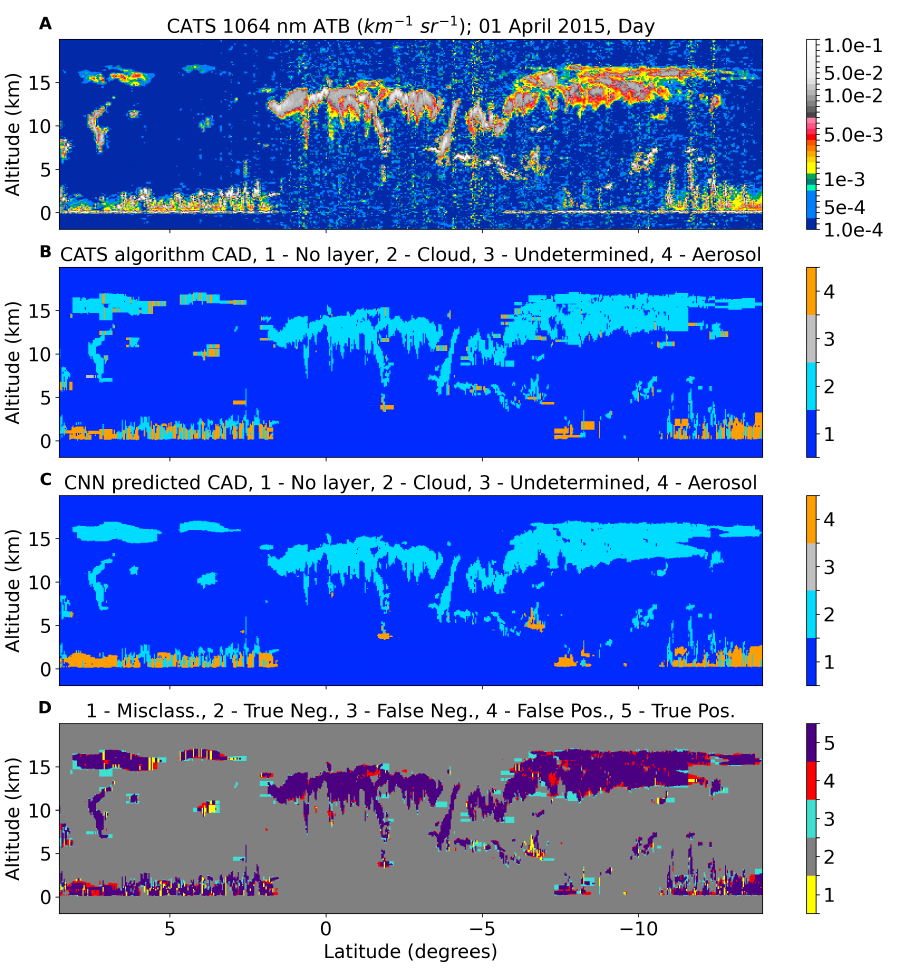
Figure 9. The same four plots as Figure 8 for a case on 1 April 2015. Misclassification of clouds and aerosols in the CATS operational CAD algorithm near the surface was a possible explanation for differences in cloud and aerosol properties observed between CATS and other lidar sensors [26,27]. Figure 10 is a classic example of a complex scene of mixed clouds and aerosols within the PBL observed by CATS on 1 April 2015 over New Caledonia. The CNN technique (Figure 10C) classifies some bins as aerosols that appear to be misclassified by the CATS operational CAD algorithm as clear-air given the 1064 nm ATB (Figure 10A) yields magnitudes consistent with aerosols in these bins (Figure 10D, red). While it is difficult to differentiate the type of feature using the CATS 1064 nm ATB alone, the CNN technique identifies more aerosols below the cumulus clouds, as demonstrated in Figure 10D (yellow). While these results are shown for a horizontal resolution of 5 km, they suggest that the CNN technique could be a powerful tool for cloud detection and clearing at the CATS native resolution (350 m), which would reduce potential cloud contamination of aerosol properties for features reported as